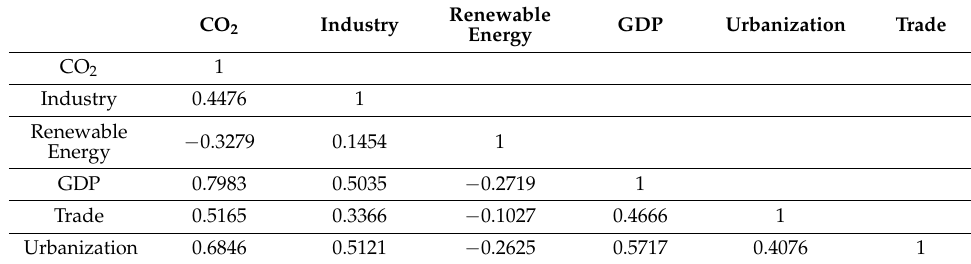
Table 2. Correlation